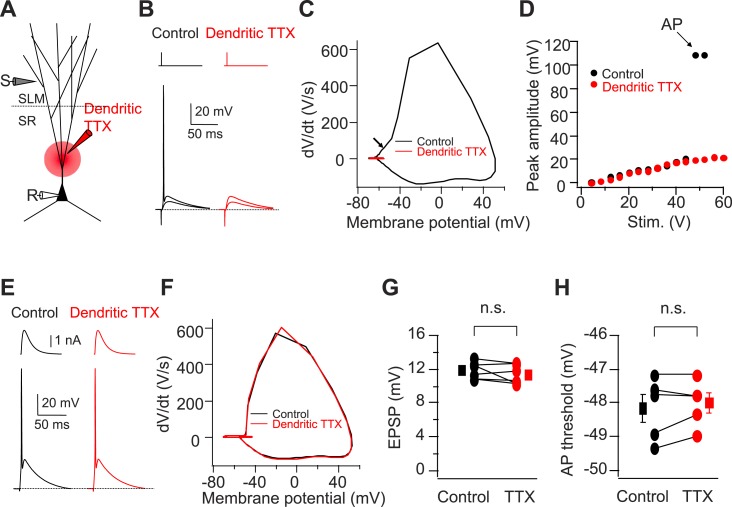
Cortically driven dendritic Na+ spikes are necessary to fire APs in CA2 PNs in response to a single PP stimulus.(A) Diagram illustrating the configuration of the experiment. (B) Superimposed voltage responses of CA2 PN in response to suprathreshold and subthreshold PP stimuli. Responses obtained in the absence (Control) or the presence of TTX applied to dendrites in SR (Dendritic TTX). Note dendritic TTX blocks AP in response to strong stimulus but does not alter subthreshold EPSP in response to weaker stimulus. (C) Phase-plane plots of dV/dt vs instantaneous voltage from data shown in (B). Arrow indicates a dendritic spike preceding a full-blown AP. (D) Input–output curve of somatic voltage response of an individual CA2 PN to PP stimulation in the absence of TTX (Control) or during local TTX application in SR (Dendritic TTX). (E) Sample traces of AP waveforms in response to somatic EPSC-like current injection. Responses obtained in the absence (Control) or the presence of TTX applied to dendrites in SR (Dendritic TTX). (F) Phase-plane plots of dV/dt vs instantaneous voltage from data shown in (E). Note lack of the rising phase preceding a full-blown AP seen in (C). (G and H) Sub-threshold EPSP evoked by PP stimulation (n = 6) and AP voltage threshold evoked by somatic EPSC-like current injection (n = 5) in the absence (Control) and the presence of TTX applied to dendrites in SR (TTX) for individual experiments (circles) and mean (squares). Error bars show SEM. SEM was smaller than symbol. n.s., not significant.